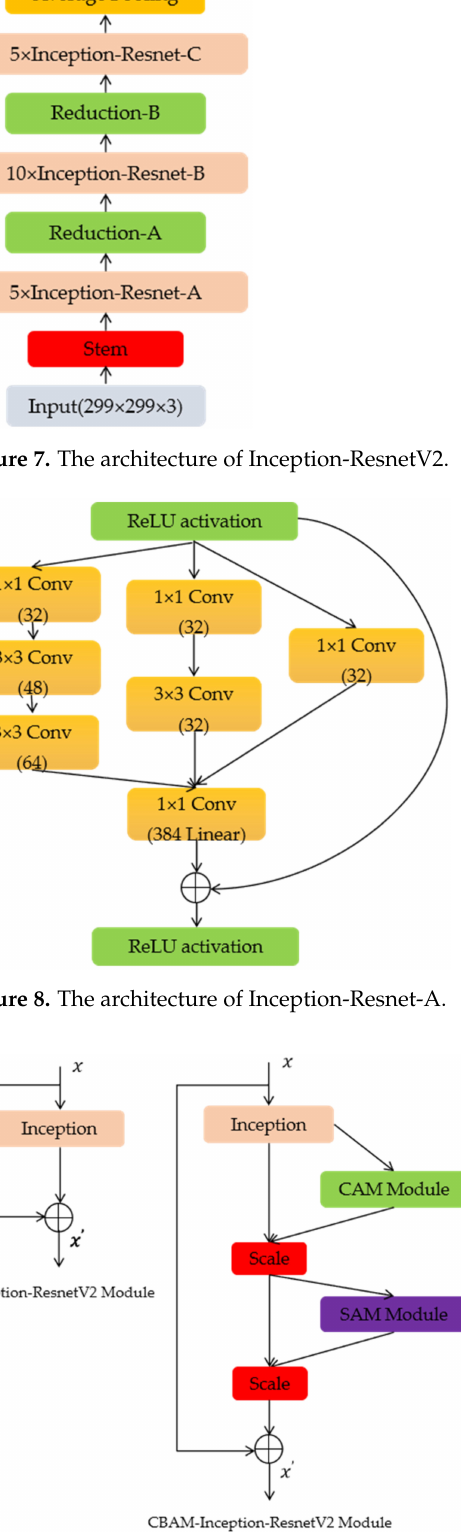
Figure 9. The architectures of Inception-ResnetV2 and